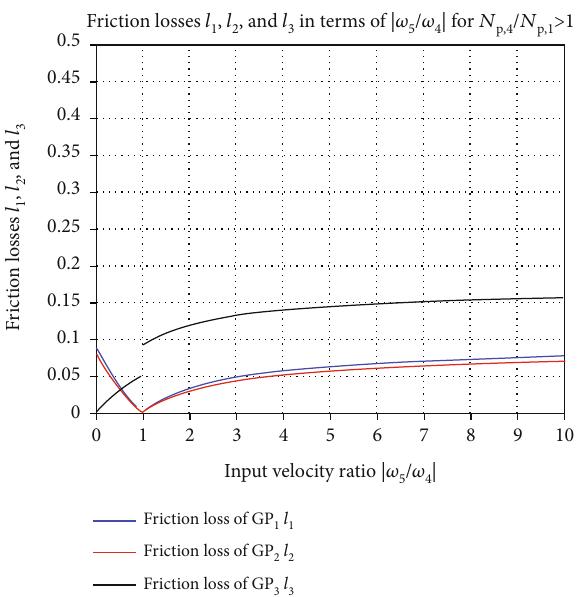
Figure 12: Friction losses with input velocity ratio.